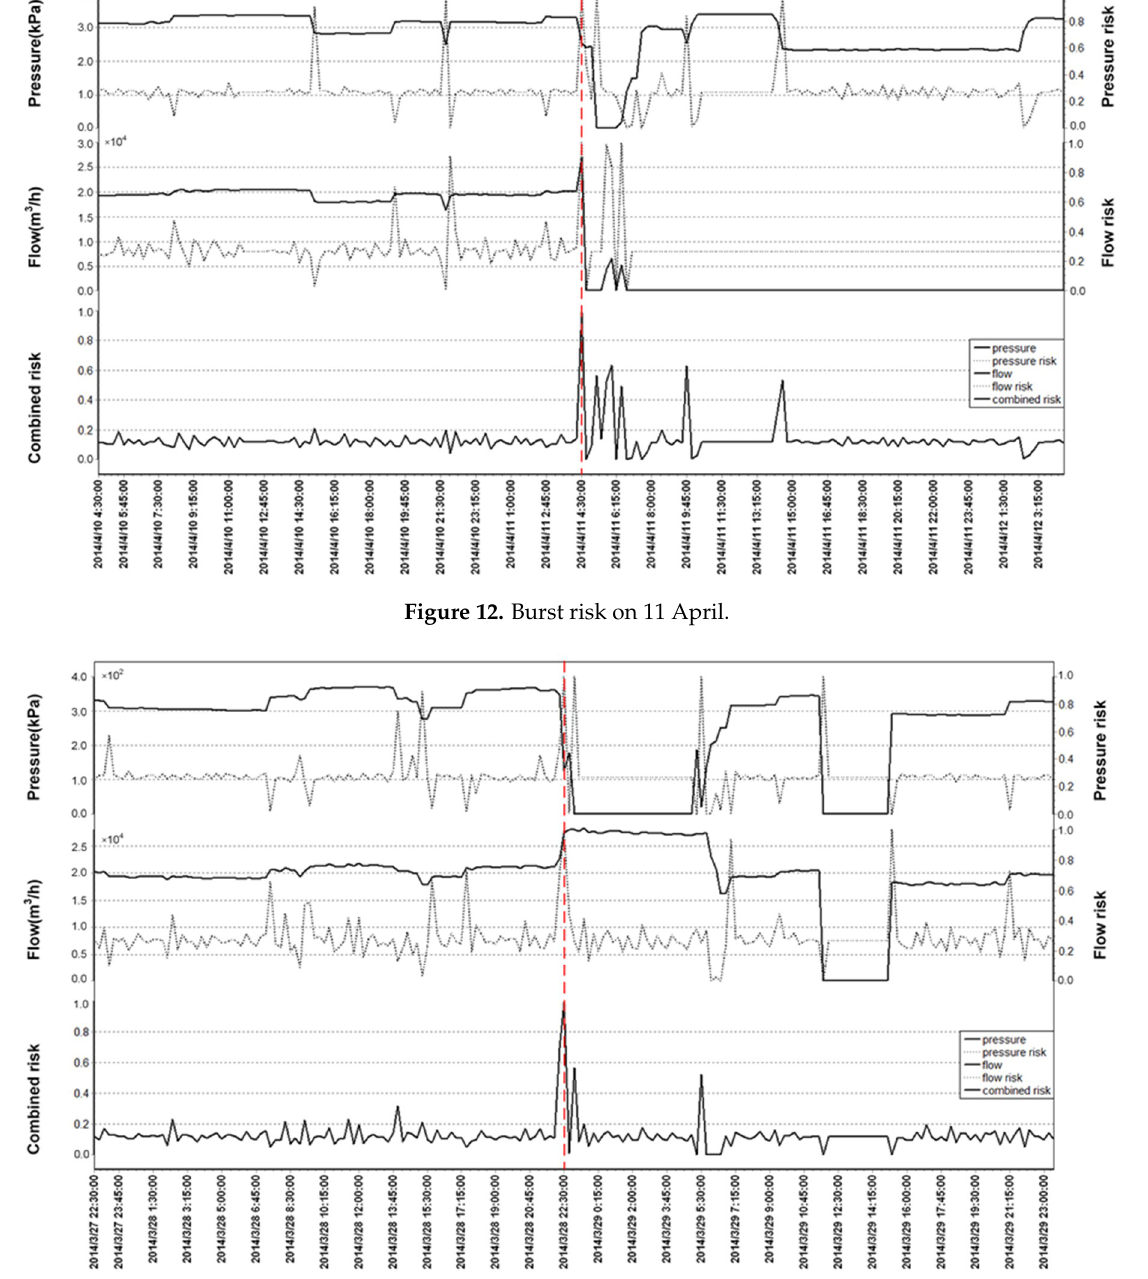
Figure 13. Burst risk on March 28.